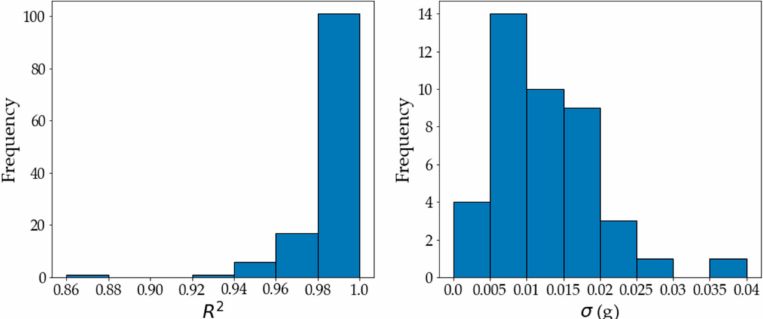
Figure 1. The R 2 values of the repeats were calculated and show the measure of how closely the data fitted the exponential line of regression, represented by Equation (1), with the corresponding growth rates. The standard deviations were calculated for the repeats of each experiment by comparing the growth rate of the repeats against the average growth rate value of that set.